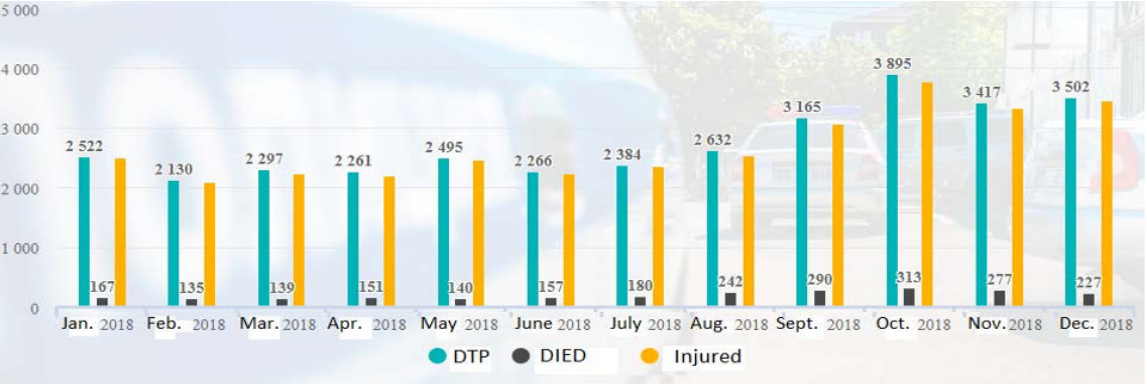
Fig. 1. Statistics of collisions with pedestrians.